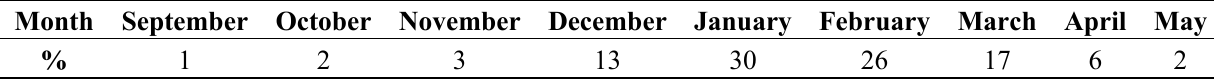
Table 1. Monthly frequency of the 934 tropical cyclones since 1848 in the Southwest Indian Ocean